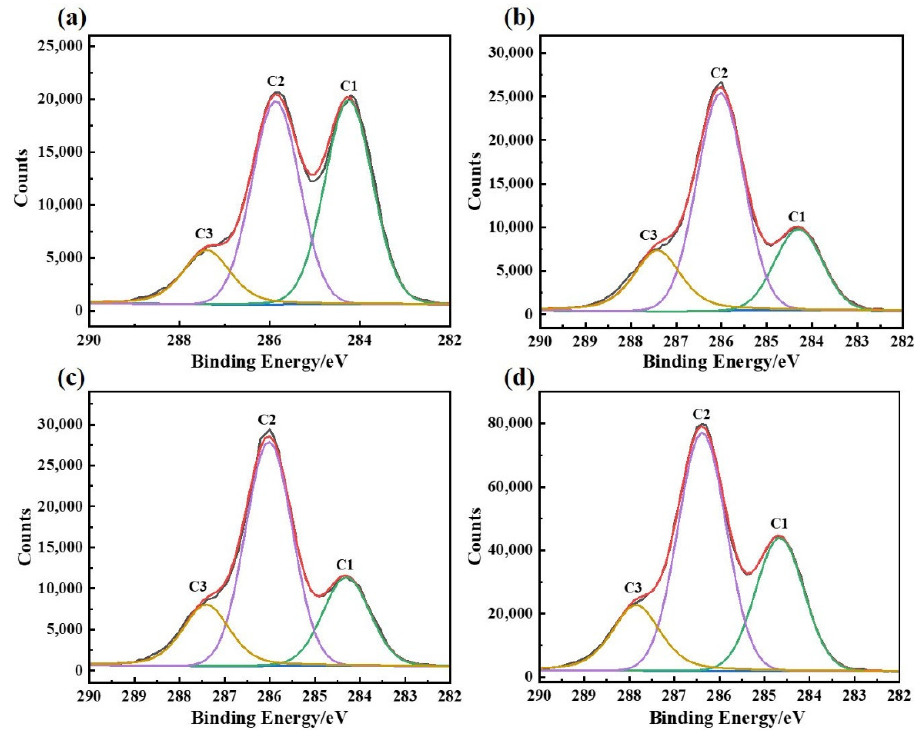
Figure 6. C1s spectra of pulp: ( a ) no bio-enzyme pretreatment; ( b ) lipase pretreatment; ( c ) xylanase pretreatment; ( d ) lipase and xylanase compound enzyme treatment.